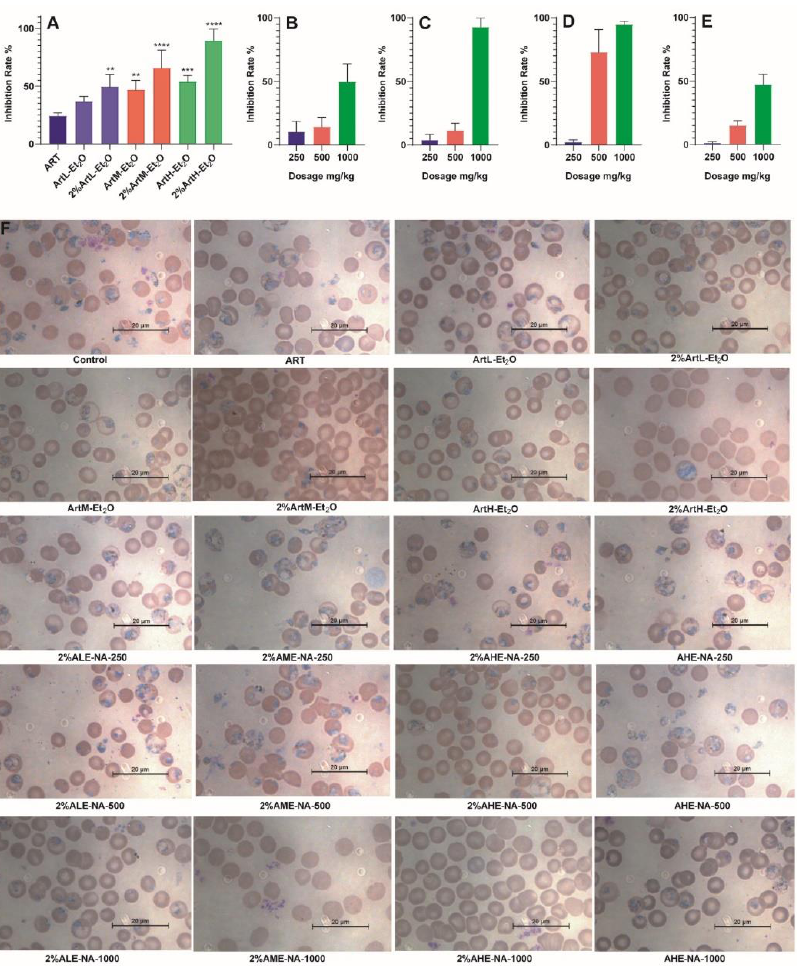
Table 1. Contents of artemisinin in different Artemisia annua L. samples. ( n = 3). Group